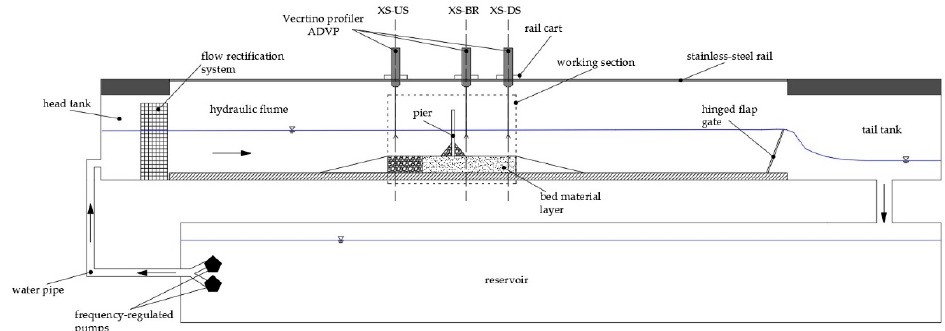
Figure 2. Scheme of the hydraulic flume setup.